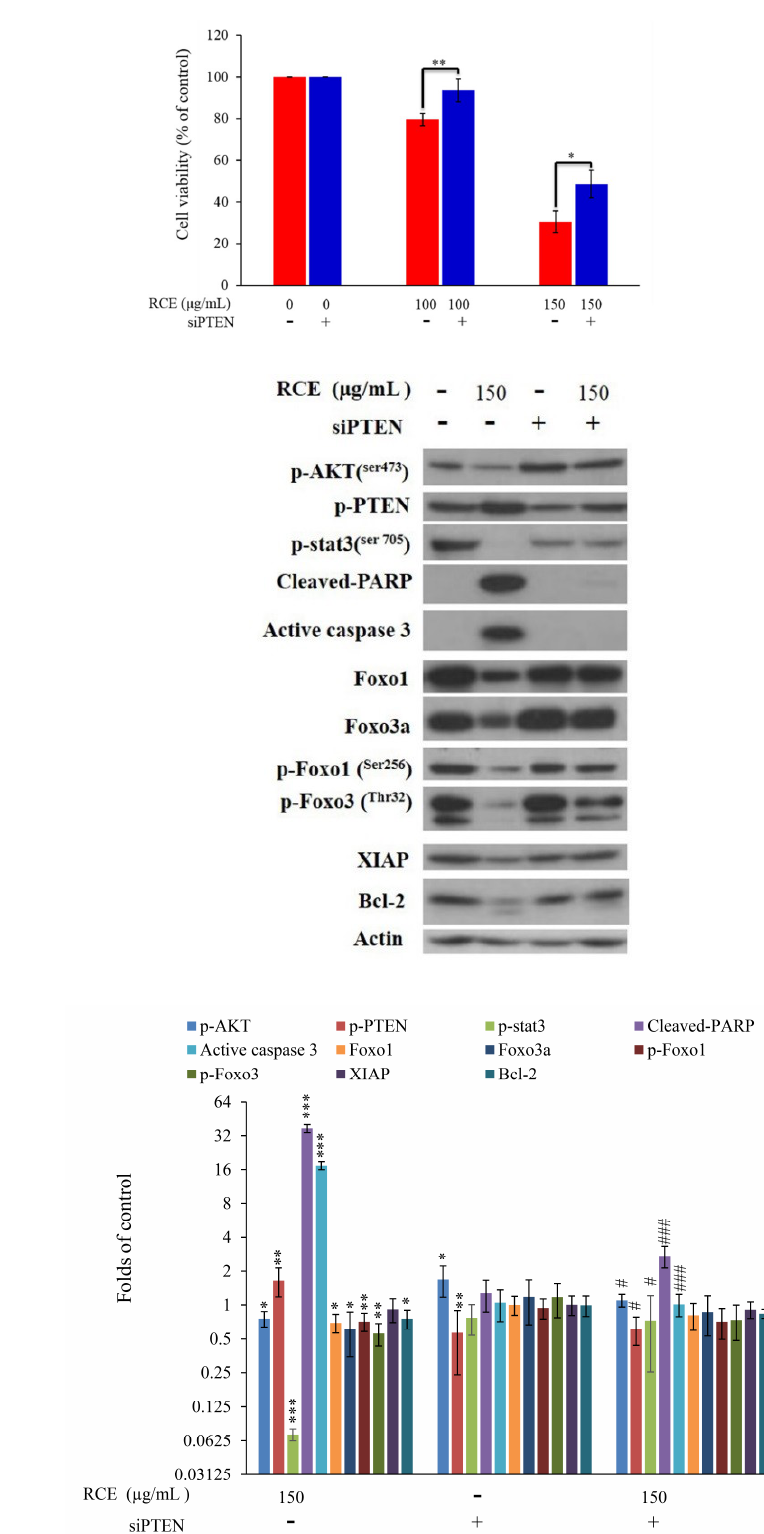
Figure 6. Antitumor e ff ect of RCE involves the disruption of MAPK, PI3K / Akt and Jak / Stat signaling pathways. ( A ) E ff ect of RCE on the localization of p-PTEN protein (1000 × ) and the cells were